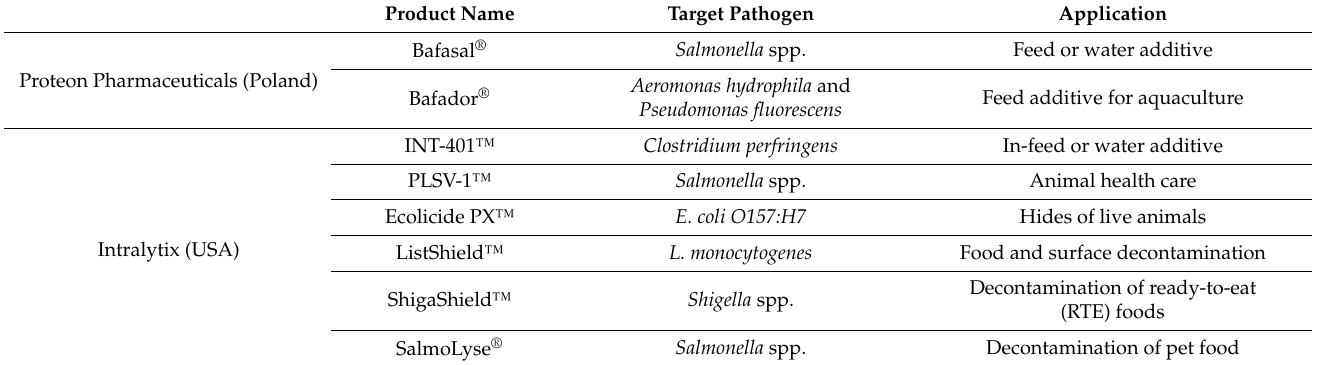
Table 4. Some commercially available phage products for food industry